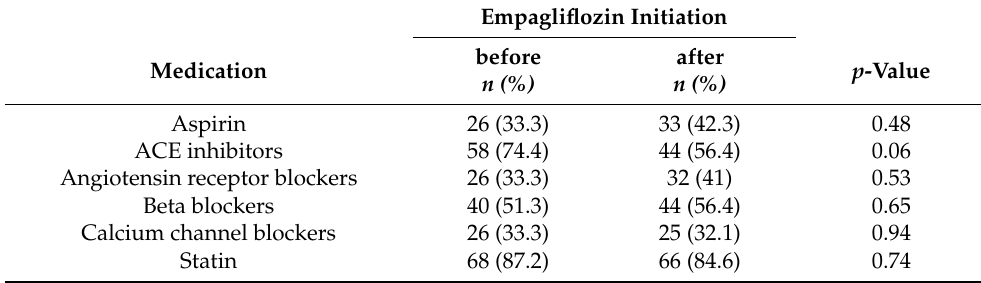
Table 2. Comparison of medication use before and after initiation of Empagliflozin.